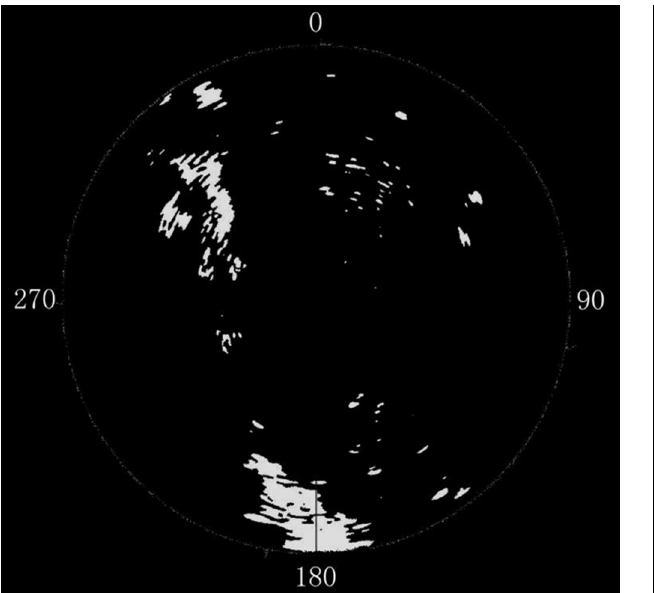
Fig. 4. Sea clutter suppression image.